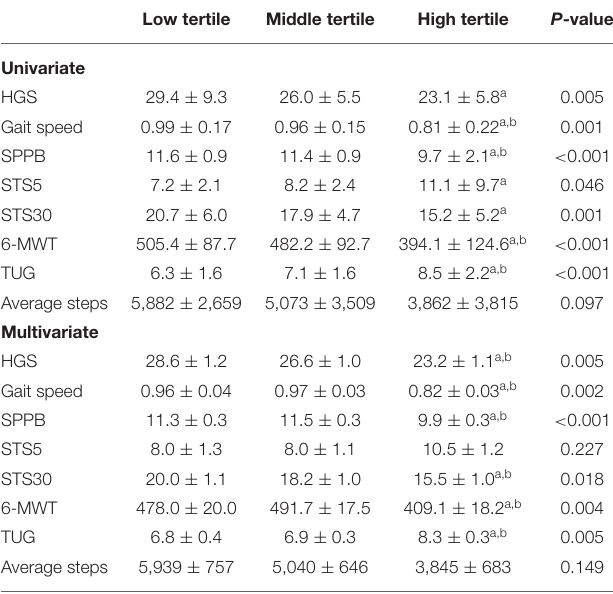
TABLE 3 | Comparison of physical performance indices according to edema index tertile. Low tertile Middle tertile High